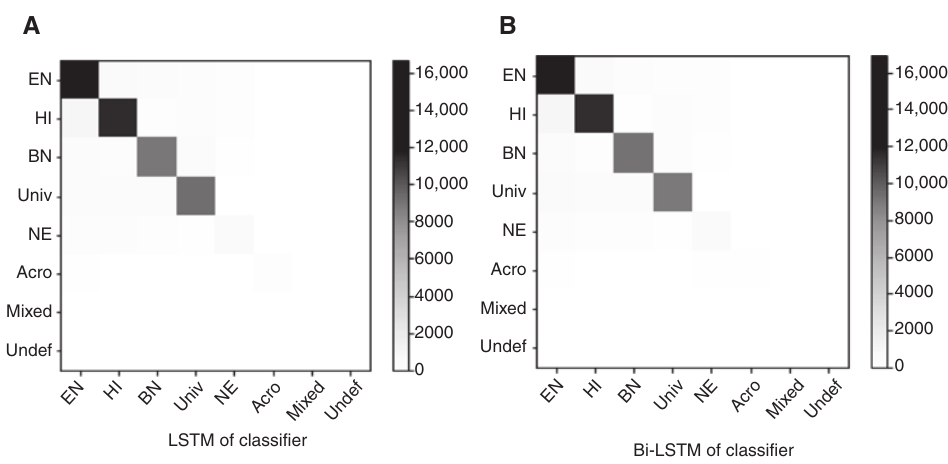
Figure 1: Confusion Matrices for the Deep Learners on the EN-HI-BN Corpus Test Set. (A) LSTM and (B) Bi-LSTM